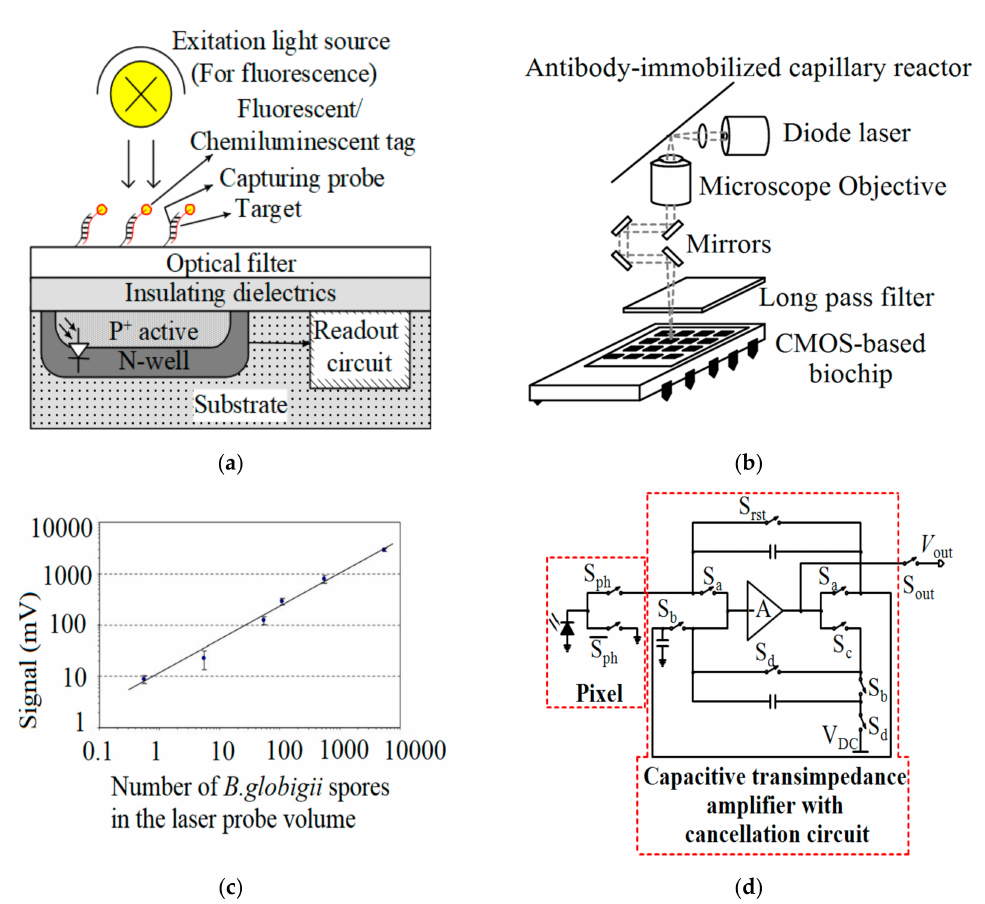
Figure 8. ( a ) CMOS-based optical sensor; ( b ) The diagram of the biochip proposed by Song et al.; ( c ) Detection of B. globigii in an antibody-immobilized capillary reactor utilizing the system shown in ( b ) [35]; ( d ) Schematic of the pixel and processing architecture of the LFIA reader proposed by Pilavaki et